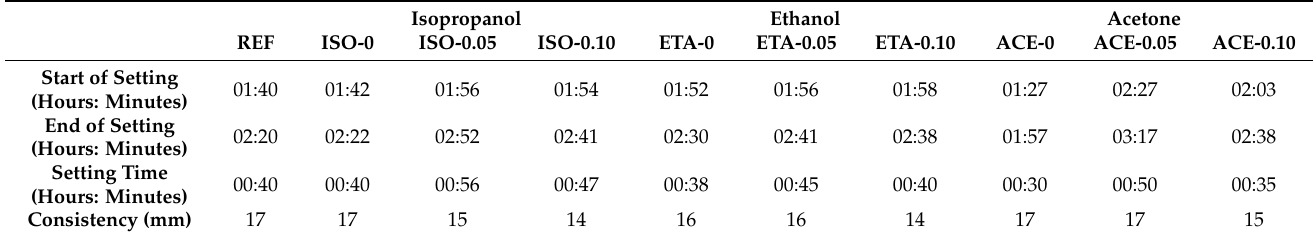
Table 2. Consistency and setting time results. (bold: parameters’ names that are specified in the following